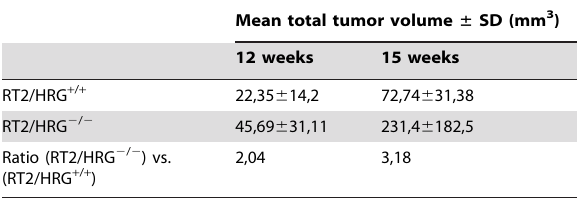
Table 1. Mean tumor volume in RT2/HRG + / + and RT2/HRG 2 / 2 mice at 12 and 15